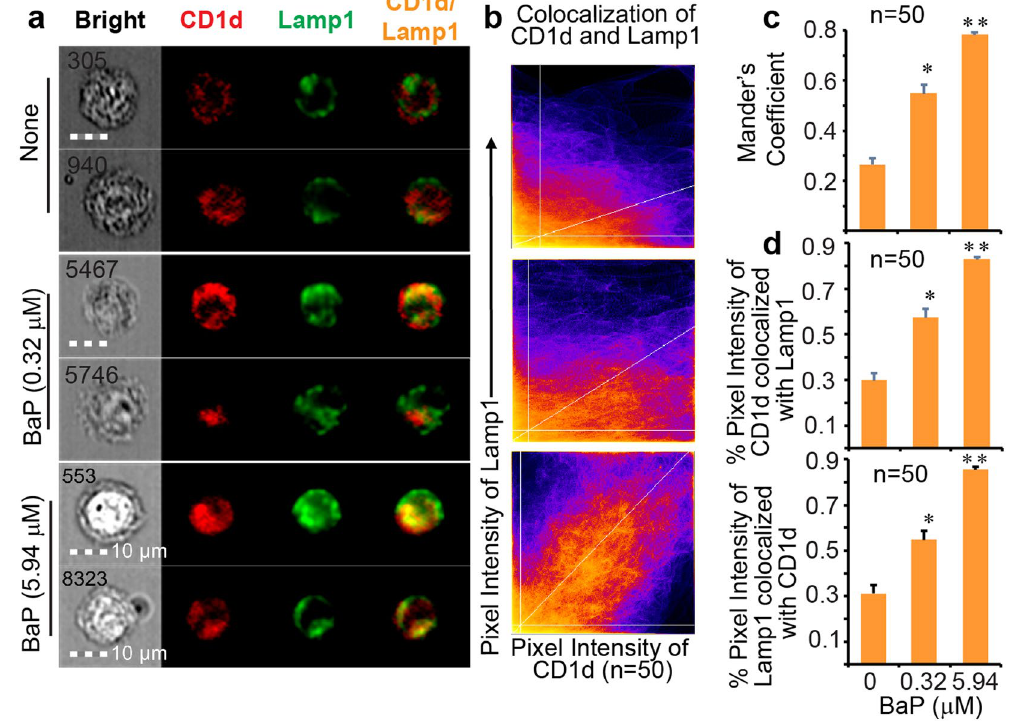
Figure 6. The CD1d protein retained in late endocytic compartments. Representative images of human DCs from the gated HLA-DR + CD11c + CD1d + Lamp1 + cells are shown together with cell identities and size bars ( a ). Fifty cells with strong co-stain and subcellular localization of CD1d and Lamp1 proteins were extracted from the gated DC population from each of three BaP exposure conditions (none, 0.32 μ M, and 5.94 μ M). In this ImageJ-Fiji analysis, the co-localized pixel intensity between CD1d and Lamp1 proteins is first shown with scatterplots ( b ). In parallel to that in Fig. 5, Mander’s coefficients were further calculated and are shown using each column to represent an average calculation of 50 cell images extracted from each of three BaP exposure conditions ( c ). The percentage of co-localized pixel intensity was also calculated and is similarly shown ( d ). Statistical significance (n = 50, p < 0.001) was obtained with Student’s t-tests in comparison to the non-exposed group ( * ) and lower exposure group ( ** ) with indicated standard errors. Data are from one experiment using cells from an independent donor. Two experiments were performed with similar